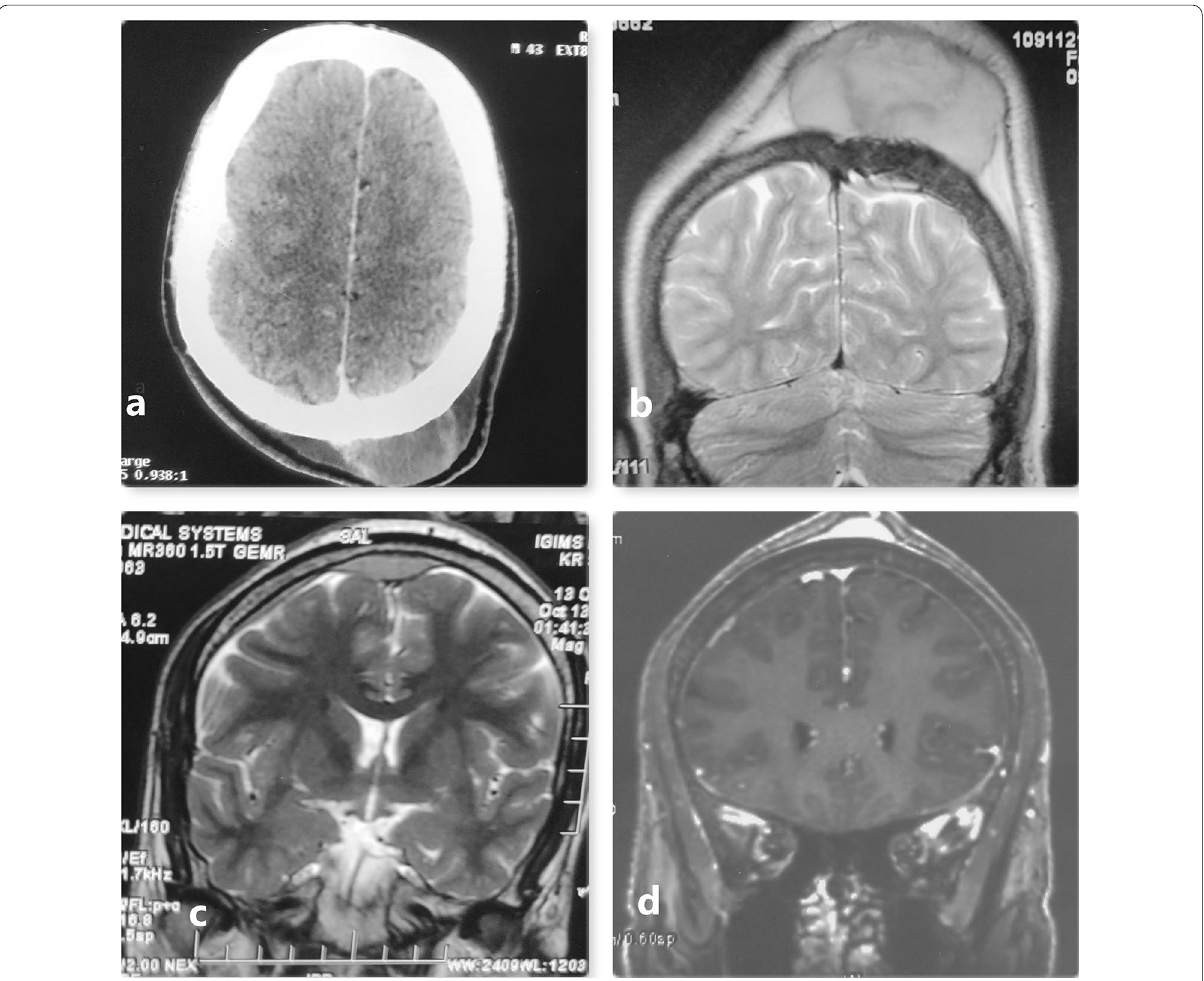
Fig. 1 a Nonenhanced computerised tomography scan suggesting lesion of size 3 cm without underlying cortical changes in calvaria. lesion is isodense. b On Coronal T2Magnetic resonance imaging (MRI) images done 6 months later shows increase in size of the lesion to around 10 cm with new lesion in with cortical changes in underlying bone suggesting selective permeation of tumour tissue. c Coronal T2 weighted image suggestive of lesion in midline with involvement of anterior sagittal sinus and left parietal region Dural involvement. d Coronal contrast MRI